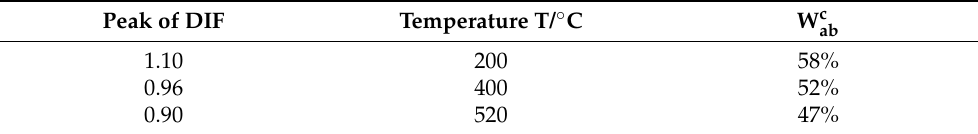
Table 5. The relationship among peak of DIF, temperature T, and the corresponding relative water absorption ratio, W c , at the peak of ab